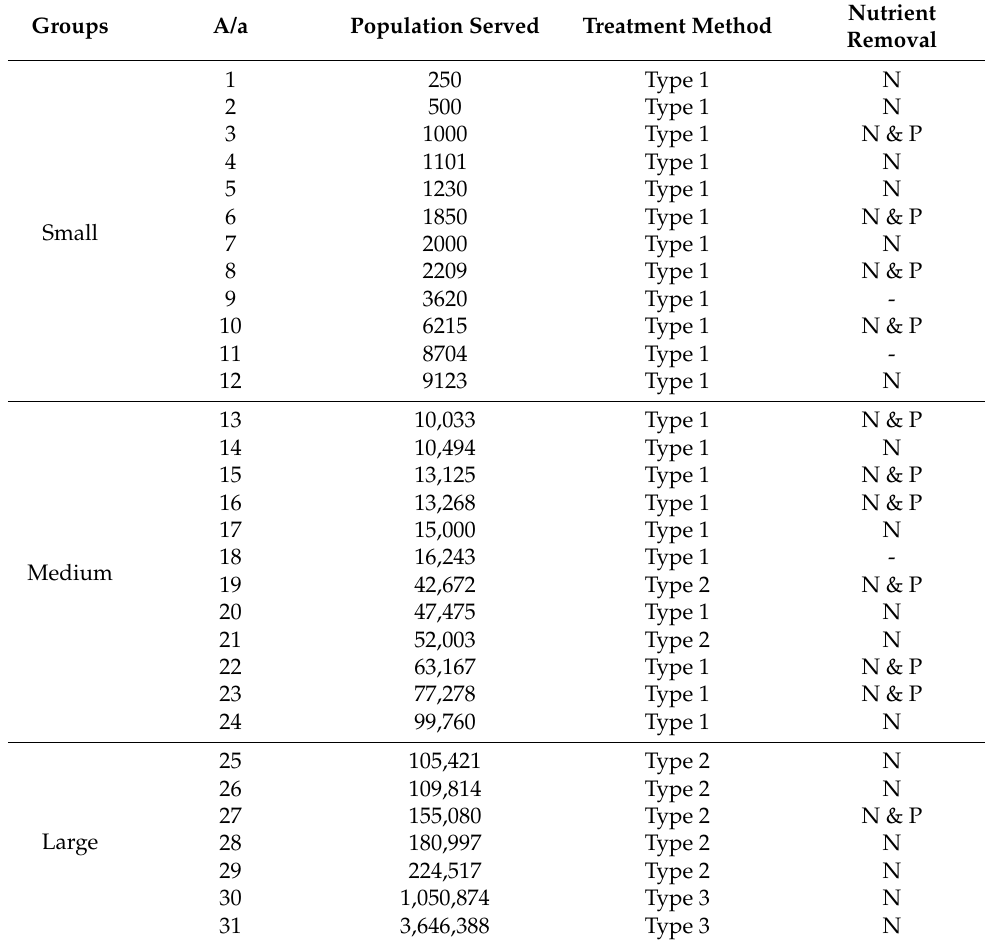
Table 1. WWTP’s population served and treatment method.